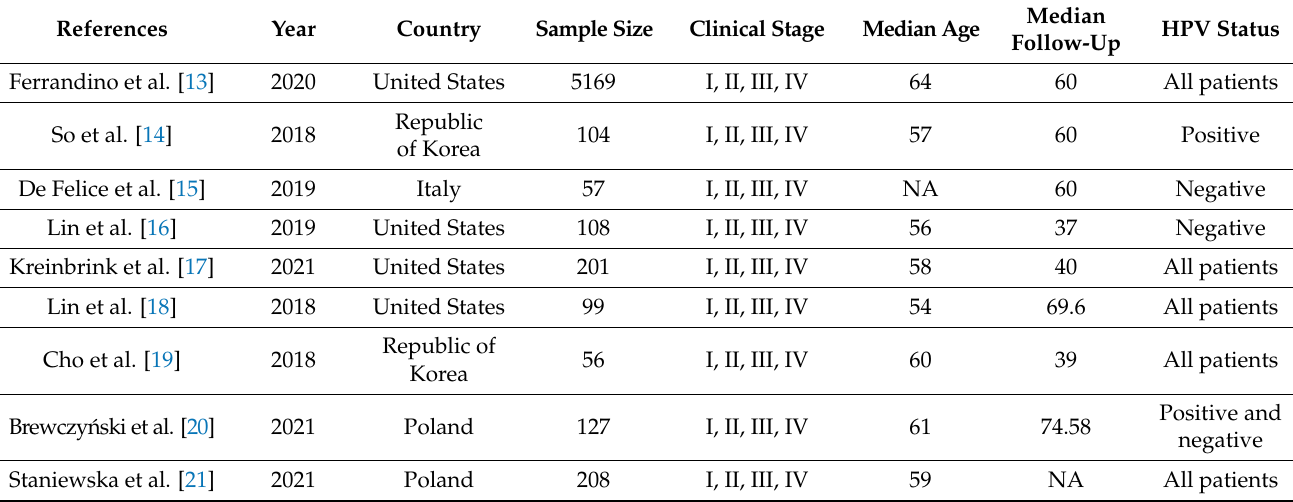
Table 1. Main features of the selected